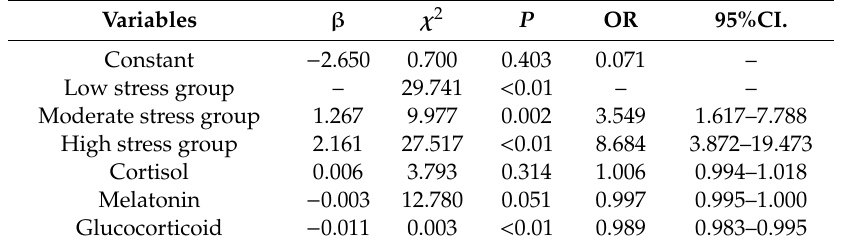
Table 6. Logistic regression analysis of occupational stress, hormone levels, and sleep disorders. Variables β χ 2 P OR 95%CI. Constant − 2.650 0.700 0.403 0.071 – Low stress group – 29.741 < 0.01 – – Moderate stress group 1.267